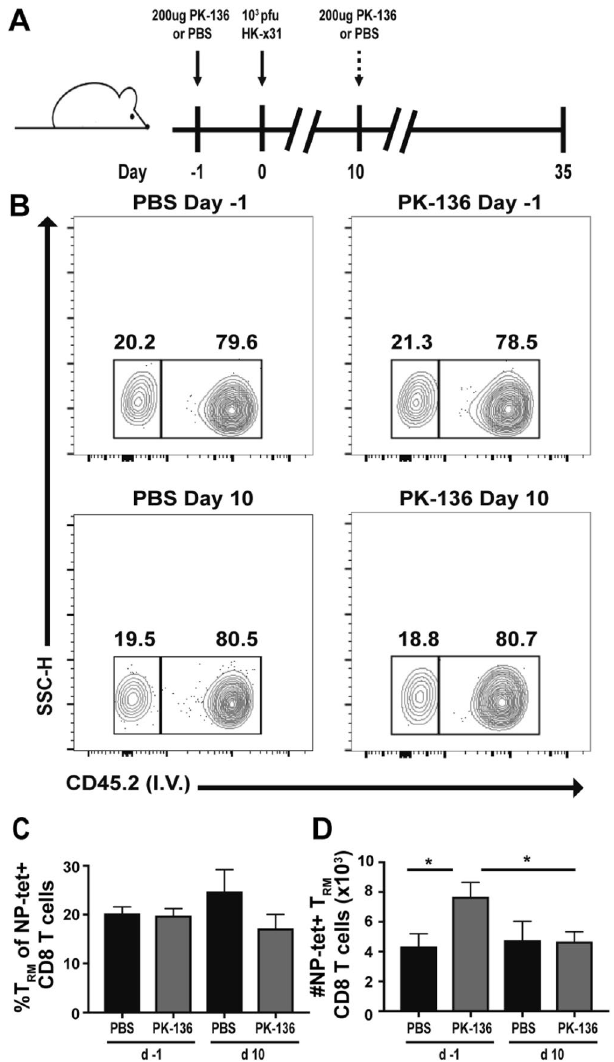
Figure 3. Removal of NK cells during CD8 + T cell priming enhances the development of lung T RM . ( A ) C57BL/6 mice were infected with 10 3 PFU x31, administered anti-NK depleting antibody at −1 or 10 dpi, and sacrificed 35 dpi. T RM were identified by lack of staining with an anti-CD45 antibody administered i.v. 3 min prior to euthanasia. ( B ) Representative flow of circulating (i.v. - ) or resident (i.v. + ) memory cells within the lung 35dpi following treatment with PBS or PK-136 on the indicated days. Previously gated on single cells, lymphocytes, CD8 + CD44 + NP-tet + cells. The frequency ( C ) and number ( D ) of NP-tet + T RM CD8 + T cells + /-SEM recovered from the lung of NK depleted (grey; depletion protocol as indicated and described in ( A )) vs PBS (black) are depicted. All graphs represent pooled data from 2 independent experiments with n = 5 mice/group/time point (total of 10 mice per group/time point). *p < 0.05; unpaired Student’s t-test with Holm- Sidak multiple comparisons